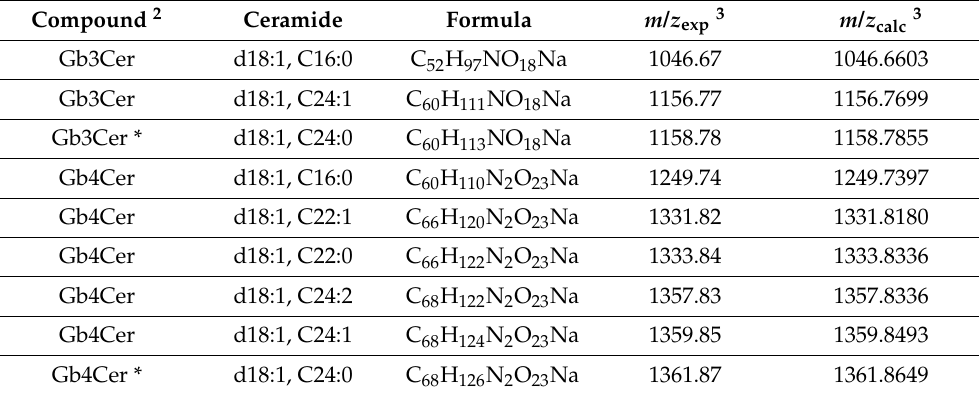
Table 1. Stx receptor GSLs of serum-free cultivated pHCoEpiCs determined by mass spectrometry combined with TLC immunodetection 1